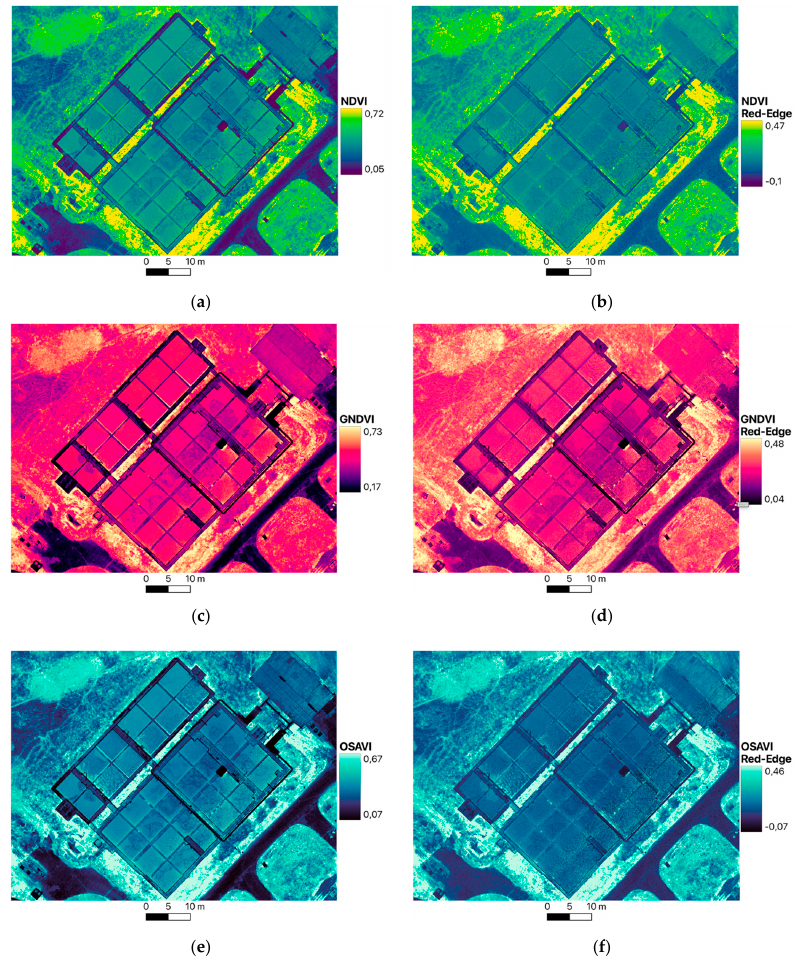
Figure 3. Maps of the spectral indices of biomass in the eastern bioreactor at the WWTP in Stara- chowice (Poland): ( a ) NDVI index, ( b ) NDVI RED-EDGE index, ( c ) GNDVI index, ( d ) GNDVI RED-EDGE indI ( e ) OSAVI index, and ( f ) OSAVI RED-EDGE